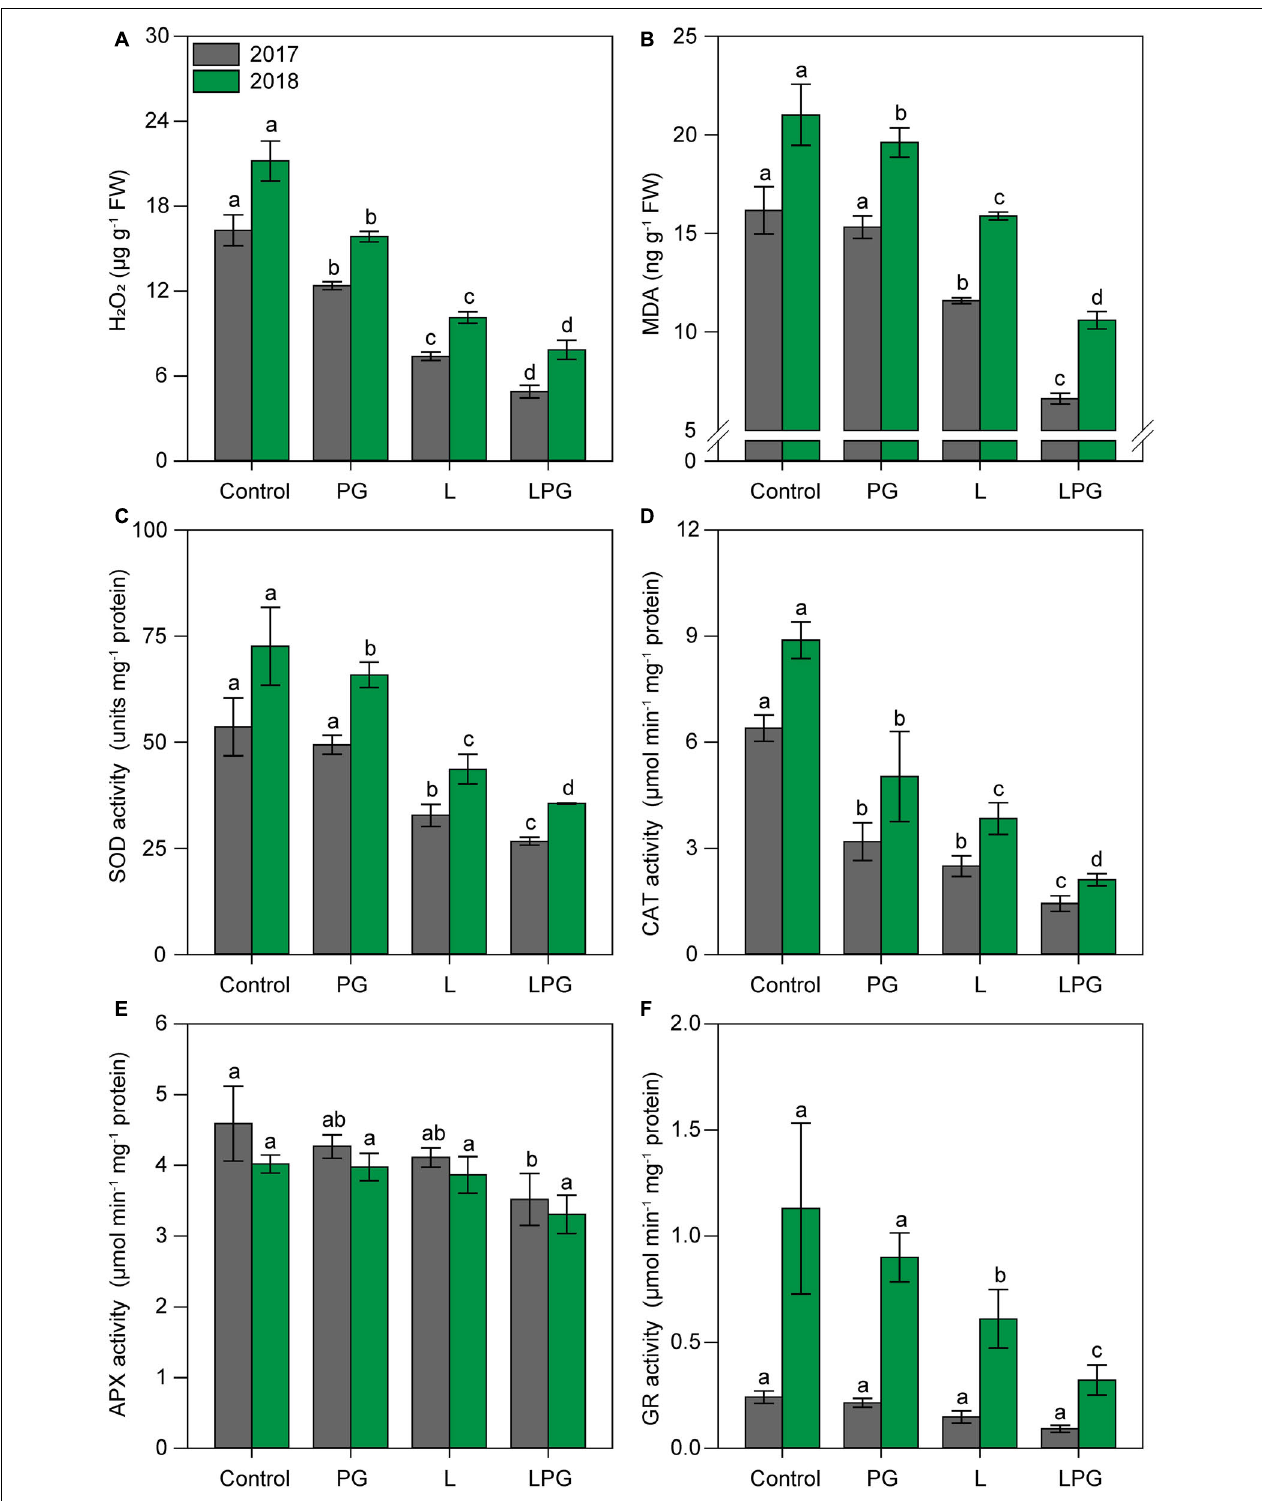
FIGURE 8 | Oxidative stress [hydrogen peroxide (H 2 O 2 ) (A) and malondialdehyde (MDA) (B) concentrations] and antioxidant enzyme activities [superoxide dismutase–SOD (C) , catalase–CAT (D) , ascorbate peroxidase–APX (E) , and glutathione reductase–GR (F) ] in maize leaves as affected by surface-applied lime (L), phosphogypsum (PG), and lime + phosphogypsum (LPG) treatments. Different lower-case letters indicate significant differences between treatments for each growing season by Student’s t -test at p ≤ 0.05. Error bars express the standard error of the mean ( n = 4).